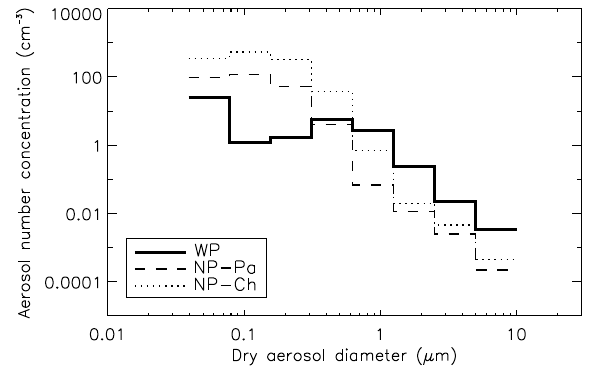
Fig. 1. Background aerosol initialisation for the three control cases: WP, NP-Pa and